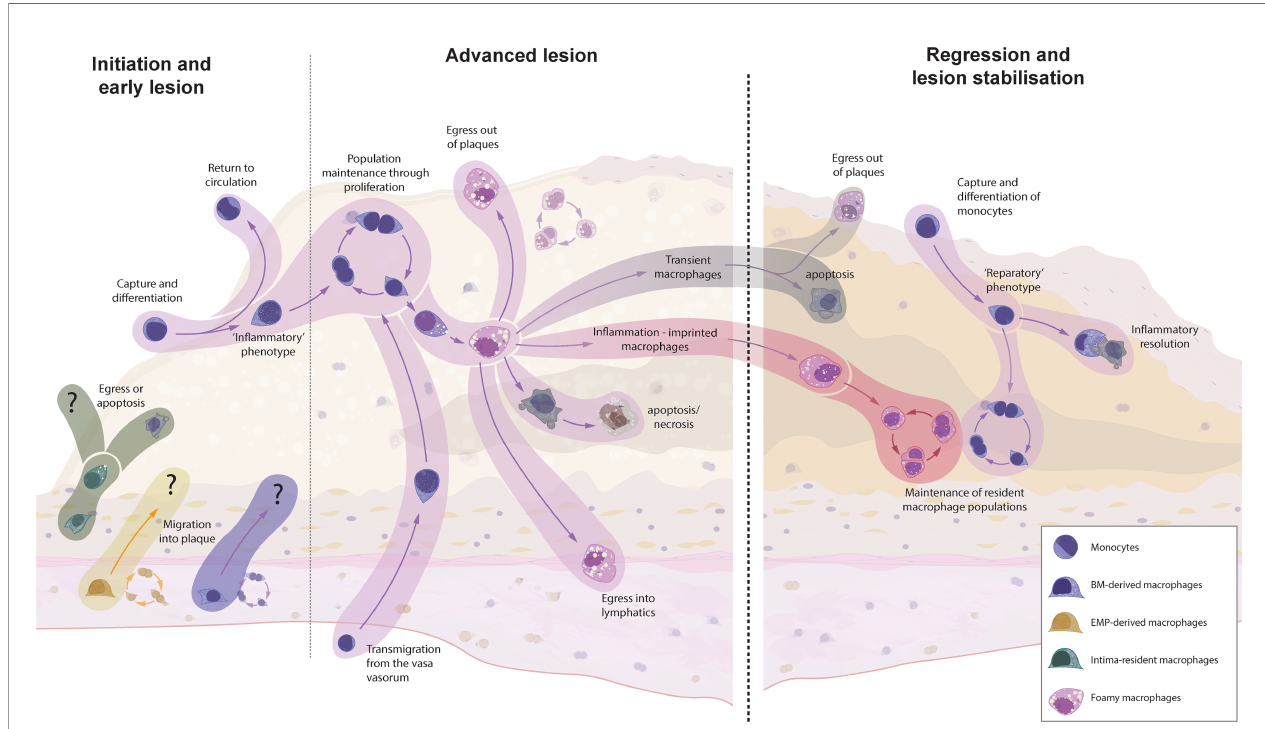
FIGURE 2 | The origin and fate of macrophages in murine models of atherosclerotic plaque formation and regression. Intima-resident macrophages are the fi rst to encounter accumulating apoB-containing lipoproteins but are replaced by recruited macrophages within weeks. It is unknown whether resident adventitial (EMP- and BM-derived) macrophages can invade the intima at any point of atherosclerosis progression or regression. Monocyte recruitment is the dominant source for plaque macrophages during early atherosclerosis, whereas local macrophage proliferation takes over at later stages. In other in fl ammatory disorders, macrophages can migrate either transendothelially or via lymphatics to clear the in fl ammatory triggers and present them to the adaptive immune system. However, hypercholesterolemia supresses emigration, leading to a continuous accumulation of cells, resulting in increased apoptosis and secondary necrosis. Upon the cessation of hypercholesterolemia, the fate of localised macrophages is yet unknown. Research from other in fl ammatory disorders has shown that, upon removal of the in fl ammatory stimuli, a number of macrophages will clear through apoptosis (transient macrophages), but in fl ammatory imprinting can de fi ne a population of surviving macrophages which have an acquired epigenetic memory - which might have detrimental effect on disease resolution and recurrence of in fl ammation. Additionally, a novel wave of monocyte recruitment de fi nes a fresh population of reparatory macrophages, which aid in tissue clearance and tissue